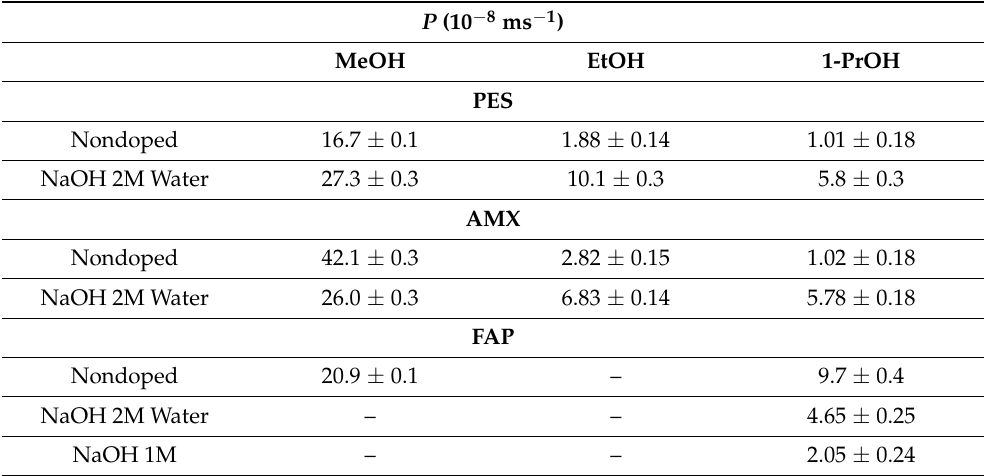
Table 5. Alcohol permeability values for PES, AMX, and FAP membranes, nondoped and doped with different doping